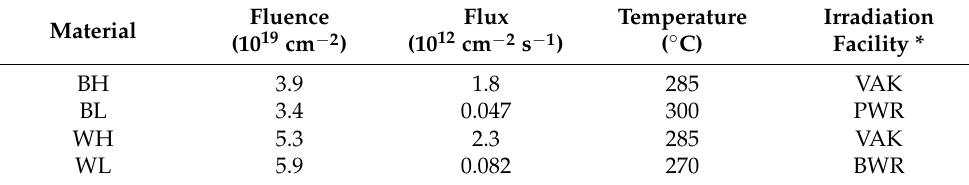
Table 2. Irradiation conditions (neutron energy E > 1